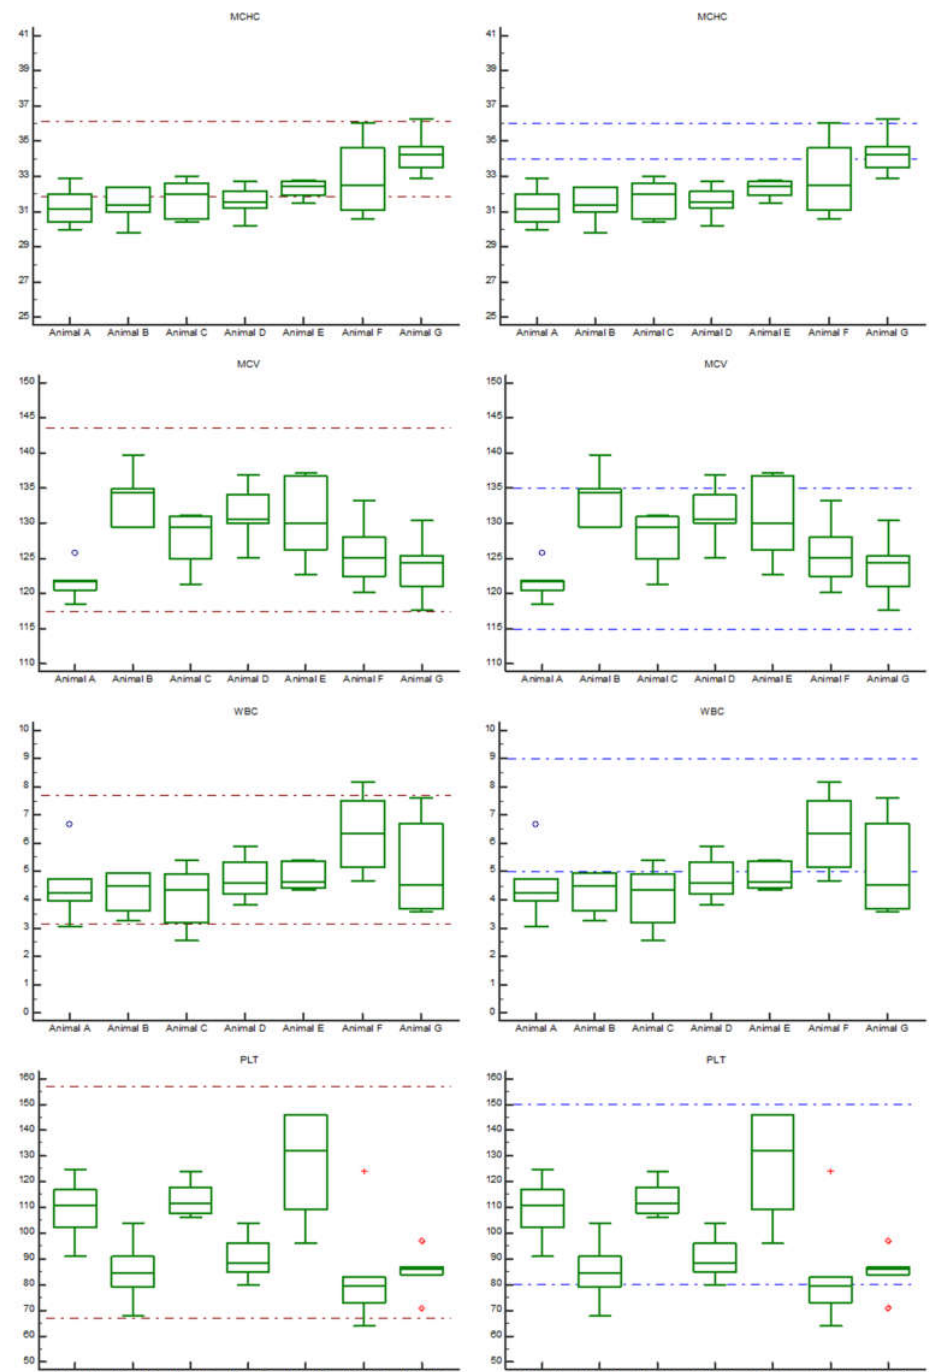
Figure 1. Comparison of individual reference intervals (iRIs) with population-based reference intervals (pRIs) obtained from the literature. The central box represents the values from the lower to upper quartiles. The middle line represents the median. A line extends from the minimum to the maximum value, excluding suspected outliers, which are displayed as separate points. The dotted lines represent the population-based reference intervals (pRIs) for managed bottlenose dolphins published by Lauderdale and colleagues [2] (in red) and by Gulland and colleagues [10] (in blue). The pRI for red blood cell distribution width (RDW) was not calculated by Gulland and colleagues. RBC = number of erythrocytes (10 9 / µ L), Hct = hematocrit (%), Hgb = hemoglobin (g/dL), MCV = mean cellular volume (fL), MCHC = mean cellular hemoglobin content (g/dL), RDW = red blood cell distribution width (%), WBC = number of leukocytes (10 3 / µ L), PLT = number of platelets (10 3 / µ